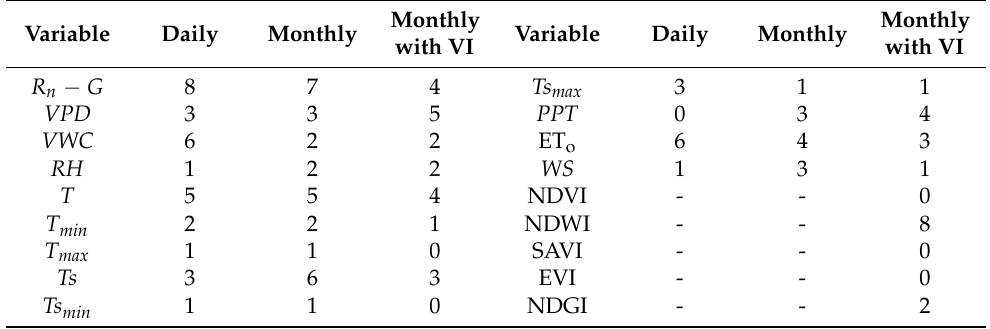
Table 6. Number of times that every variable is selected in a site-specific equation for daily, monthly, and monthly with VI